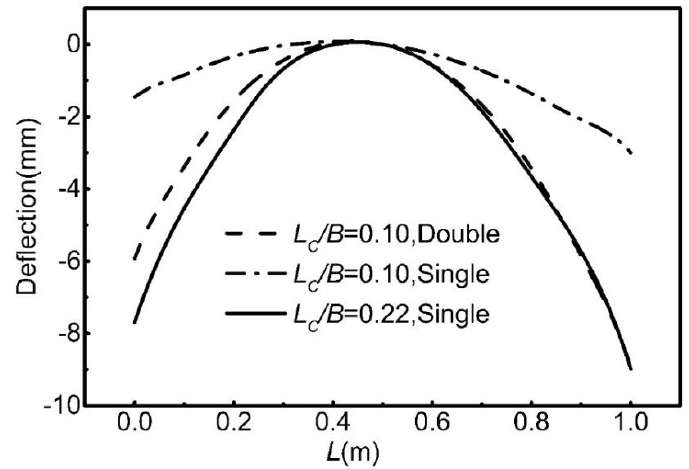
Figure 22. S L 1 -S L 1 section flexure lines for different heating conditions.